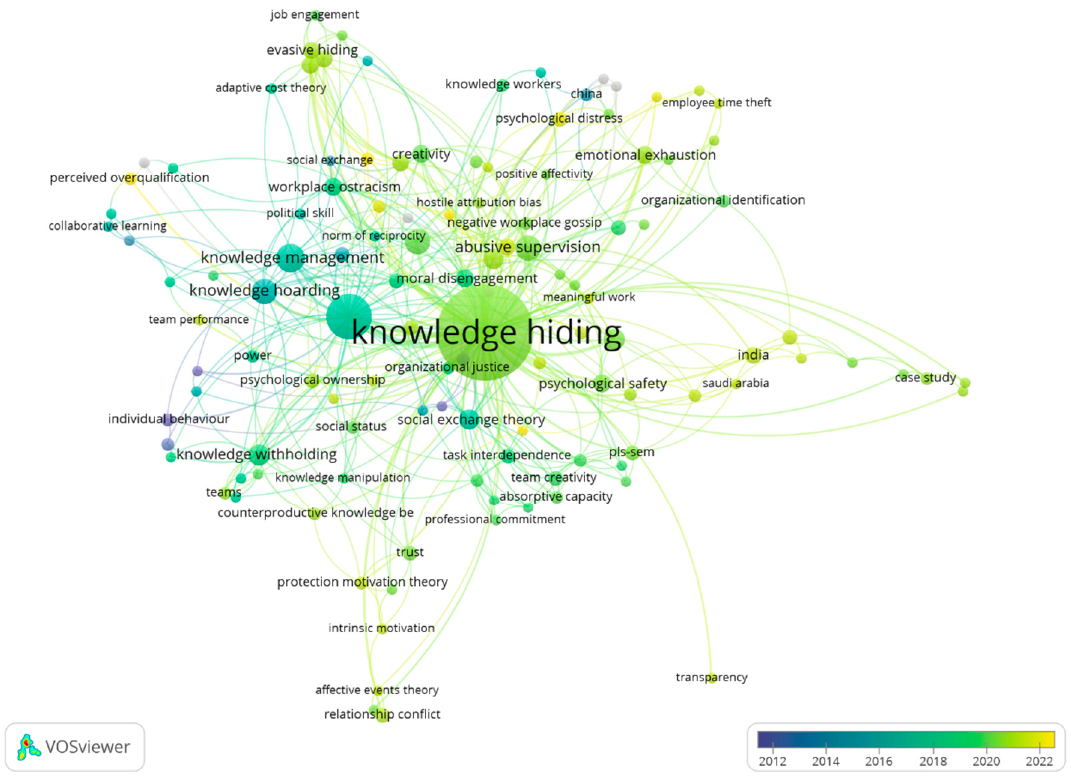
Figure 3. Keyword co-occurrence network. Table 4. An example of the summarizing of empirical knowledge-hiding studies.